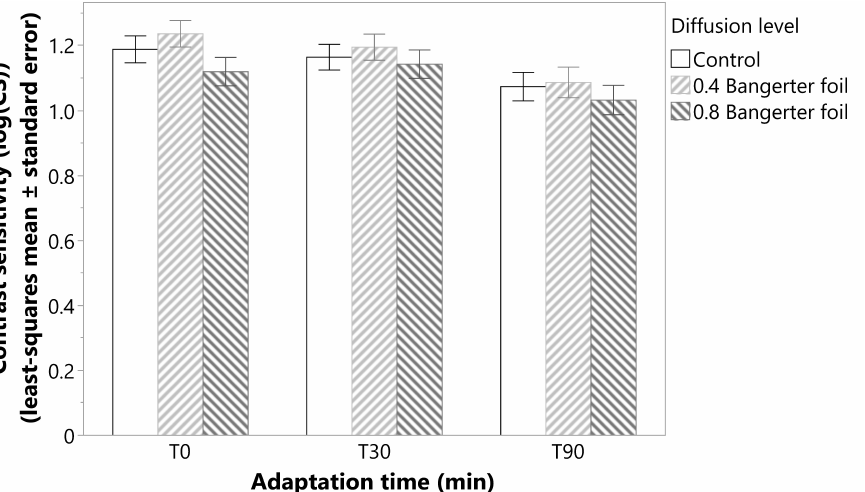
Figure 5. Least-squares mean ± standard error in log(CS) for the different diffusion levels over the adaptation time in min ( n =19